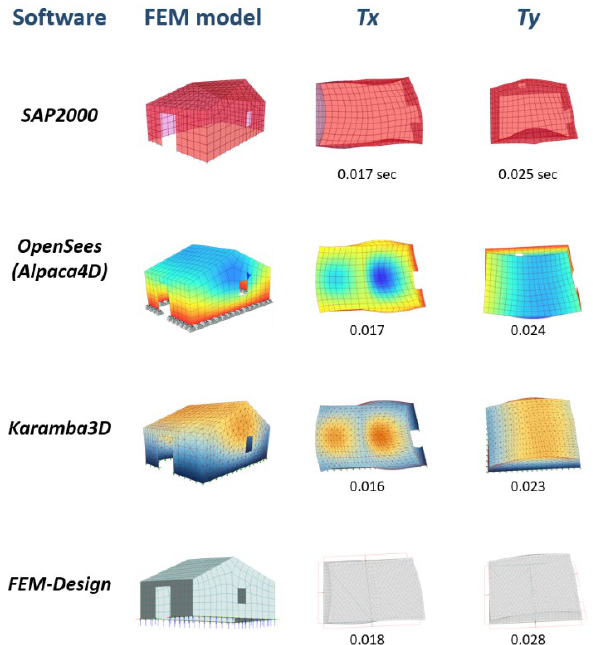
Figure 8 . Analysis of the vibration periods of the same model.